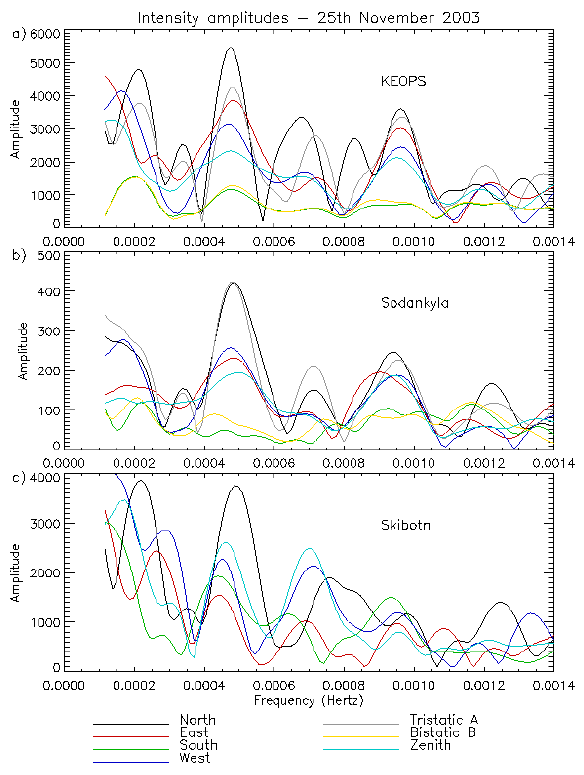
Fig. 2. Amplitudes of Lomb-Scargle periodograms for FPI intensi- ties for (a) KEOPS, (b) Sodankyl¨a, and (c) Skibotn, on 25 Novem- ber